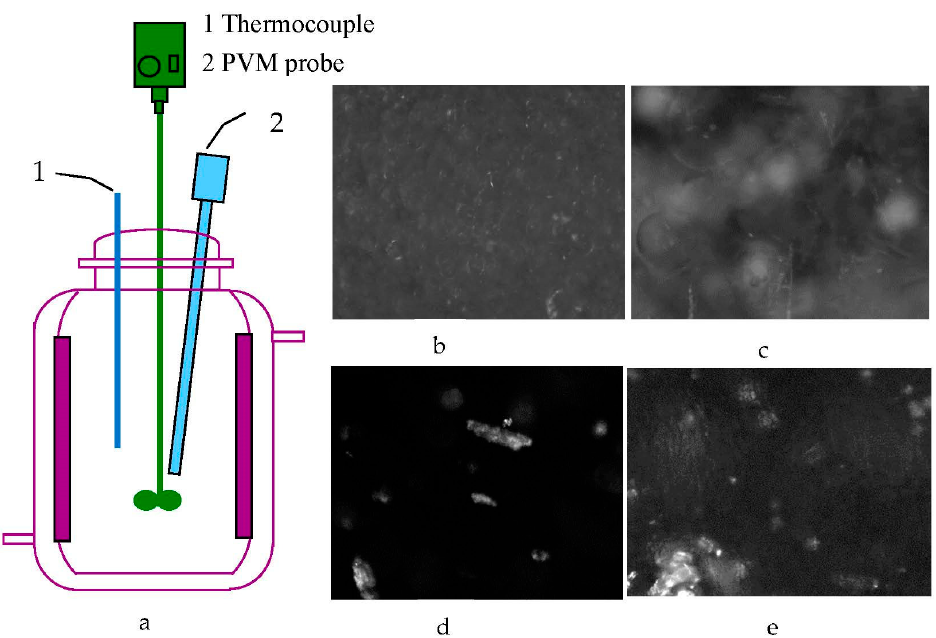
Figure 2. ( a ) Setup for crystallization experiments and representative PVM images; ( b ) when LLPS took place; ( c ) when nucleation took place in the presence of LLPS; ( d ) seeds in the solution without LLPS; ( e ) seeds in the presence of LLPS.